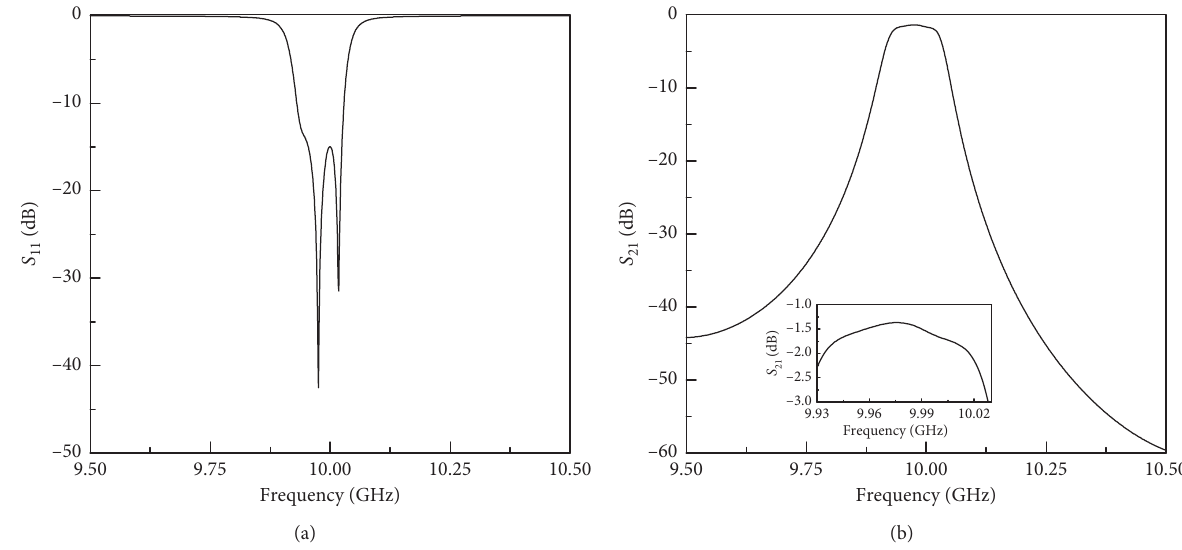
Figure 5: S-parameters of RWG to SIW feeding structure: (a) reflection parameter and (b) insertion loss; the inset of Figure 5(b) represents a zoomed view of region of interest.